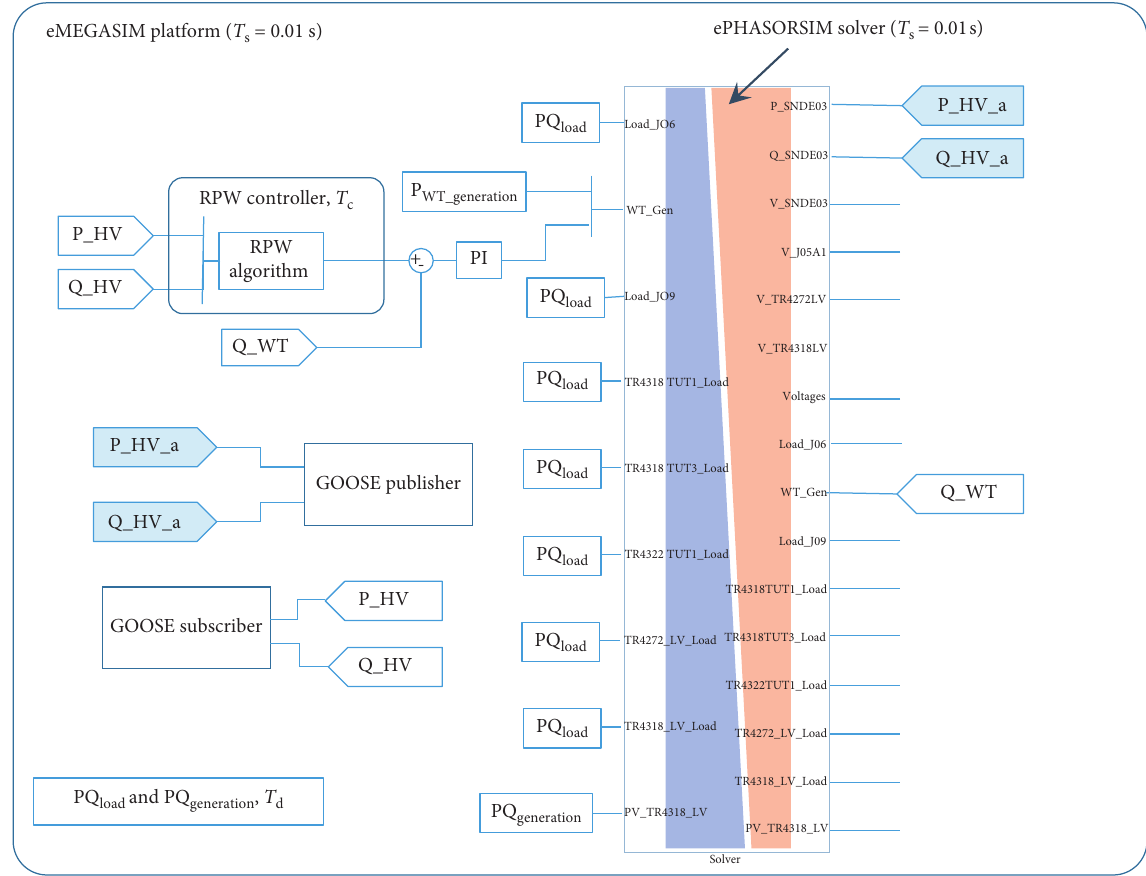
Figure 6: The emulated system and the RPW